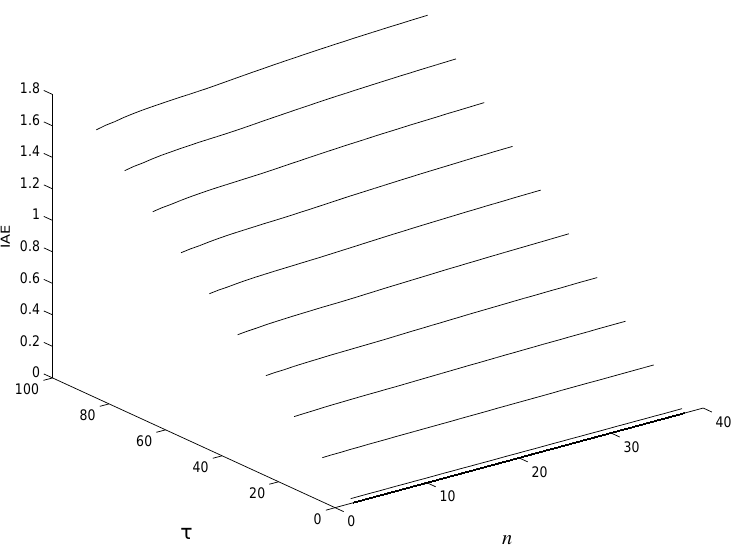
Figure 10. Values of IAE for different values of τ and n (process order) with a PID controller tuned according to the benchmark tuning rules.